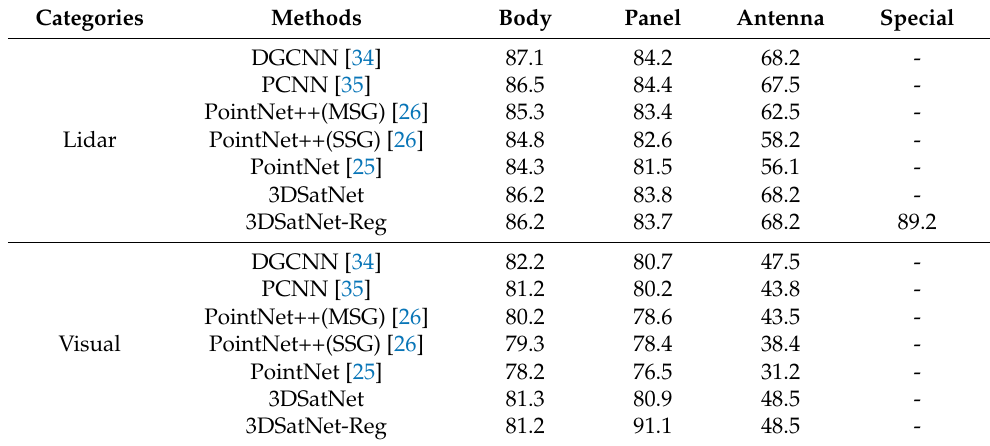
Table 6. Accuracy evaluations of the component segmentation result via different models